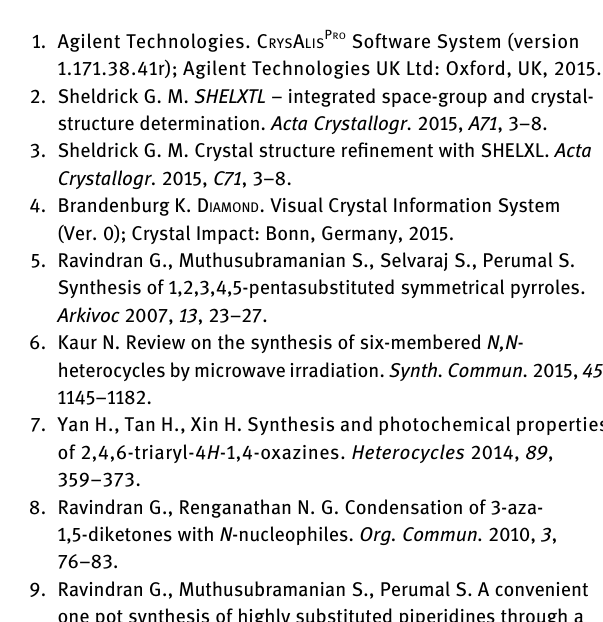
process. Therefore, in order to improve the purity of the product, we use the recrystallization method to quickly and easily convert the powdered product into a crystal. The title molecule is located on a two fold axis (see the figure). The bond lengths and bond angles of the crystal structure are within a reasonable range. Meanwhile, there is no hydrogen bonding interaction between molecules. The torsion angles of N1 – C6 – C7 – O1 and N1 – C6 – C7 – C8 are 10.95 ° and − 167.80 ° respectively. In addition, the dihedral angle between half of the benzene ring plane (C2 – C3 – C4 – C5) and the other benzene ring plane (C8 – C9 – C10 – C11 – C12 – C13) is 87.87(7) ° .